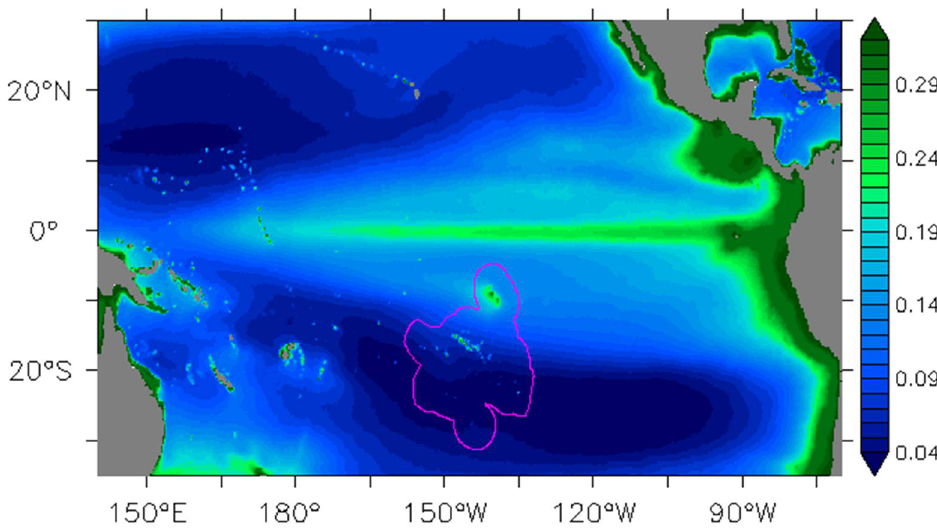
Figure 1. The 1998–2014 annual average of chlorophyll-a concentrations (Chl, mg/m 3 ) from the satellite-derived GlobColour Chl AVE product. The purple line delineates the French Polynesian Exclusive Economic Zone (EEZ).